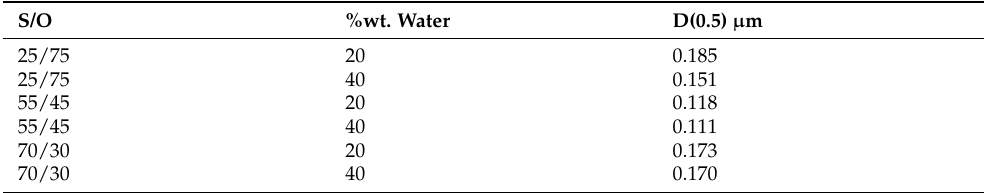
( b ) Figure 7. ( a ) oily streaks and ( b ) mosaic texture for the dispersed system in the S/O 25/75 dilution line with 20% of water content. 3.5. Rheological Behavior The case of the S/O 70/30 dilution line is presented to begin the description of the rheological behavior. When this system contains 20% water, it behaves like a liquid with very little viscoelasticity. In the amplitude scan (Figure 8a), it can be seen that the viscous component (G’’) remains above the value of the elastic component (G’) throughout the range studied. Likewise, in Figure 8b, G’’ is greater than G’ in almost the entire frequency range studied; the elastic, viscous component and, therefore, the complex modulus (G*, see Figure 8c) increase with the frequency, similar to the behavior of very dilute solutions of water-soluble polymers [47]. The little viscoelasticity of this system can be reiterated in Figure 8c, where it can be seen that the complex viscosity maintains a constant value of around 51 mPa.s. The latter shows that, in a steady-state test, the viscosity curve would